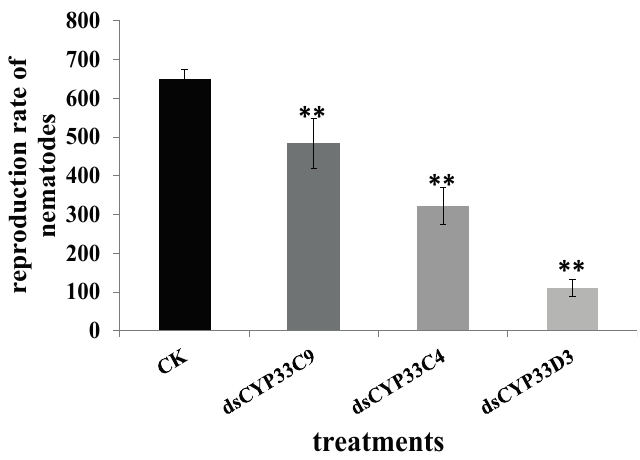
Figure 7. Analysis of susceptibility of B. xylophilus to to commonly used pesticides. ( A ) Microscopy analysis of morphology and locomotion of B. xylophlilus after soaking in two commonly used pesticides. B. xylophilus without RNAi treatment soaked in abamectin (a) and emamectin (a1) solution were conducted as controls. The treatments were ds CYP33C9 -treated B. xylophilus soaked in abamectin (b) and emamectin (b1) solution, ds CYP33C4 -treated B. xylophilus soaked in abamectin (c) and emamectin (c1) solution, ds CYP33D3 -treated B. xylophilus soaked in abamectin (d) and emamectin (d1) solution. Scale bars = 100 µm; ( B ) Increases in mortalities of B. xylophilus with RNAi after soaking in pesticides. B. xylophilus without RNAi treatment with a pesticide and those injected with ddH 2 O were considered as controls. Data represent mean values ± SD from three independent experiments. Bars show standard errors of the mean. Asterisks on top of the bars indicate statistical significance (** p < 0.01, Student’s t -test) of differences between the dsRNA-treated and